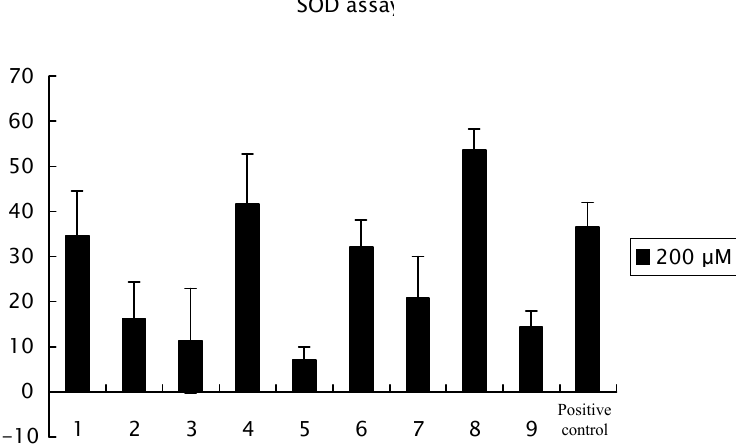
Figure 4. Radical scavenging effects of suffruyabiosides A ( 1 ) and B ( 2 ) and known compounds 3 – 9 . After the incubation of the plate at 37 °C for 20 min, read the absorbance at 450 nm using an ELISA reader. This assay was repeated two times. Data are the mean ± SD of three determinations. SOD